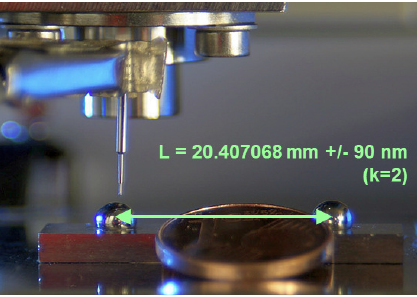
Figure 5. Distance measurement on a ball bar.